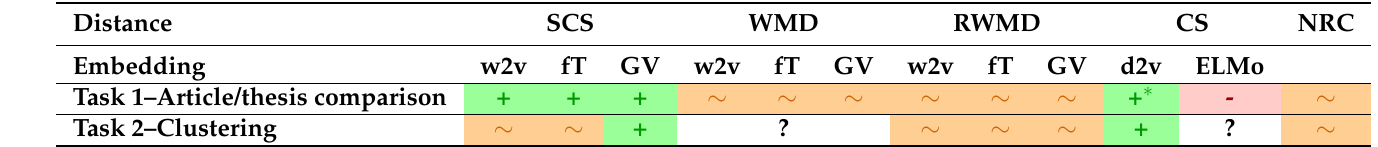
Table 5. Summary of the results. “+” means good results, “ ∼ ” average results, and “-” bad results. Results that were not possible to evaluate (e.g., the calculation took too long) are indicated by “?”. The combination of d2v and CS is labelled as good because the results with the papers are very positive. However, for very long documents, it exhibited a bumpy decrease instead of a monotonic behavior (therefore we marked it with a “*”. However, for the clustering case, its behavior is superior to Gv + RWMD, though the latter also works